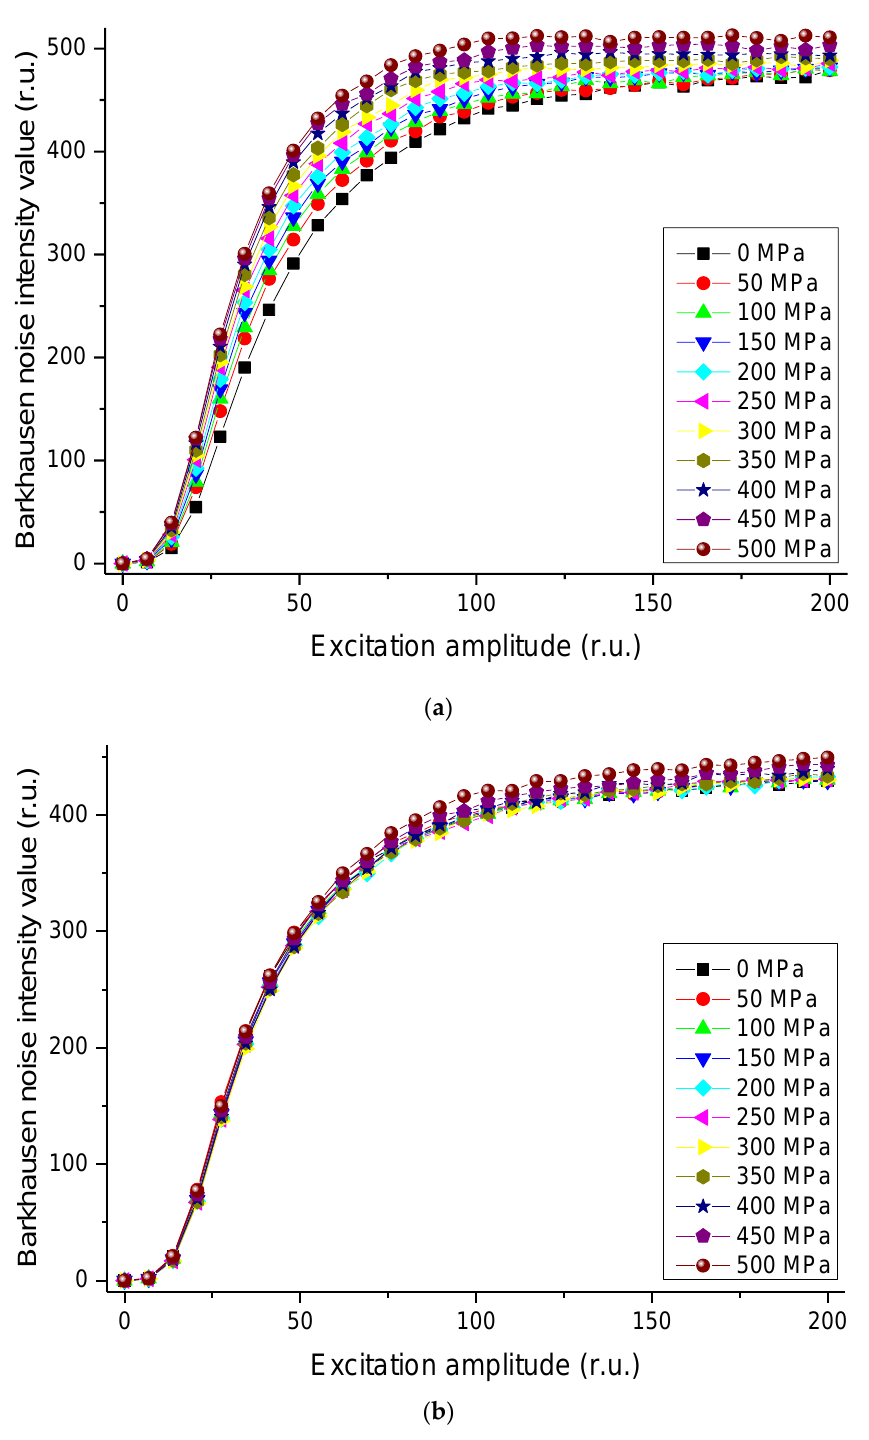
Figure 7. Measured magnetic Barkhausen noise intensity values for indicated tensile stresses in ( a ) longitudinal and ( b ) perpendicular directions.